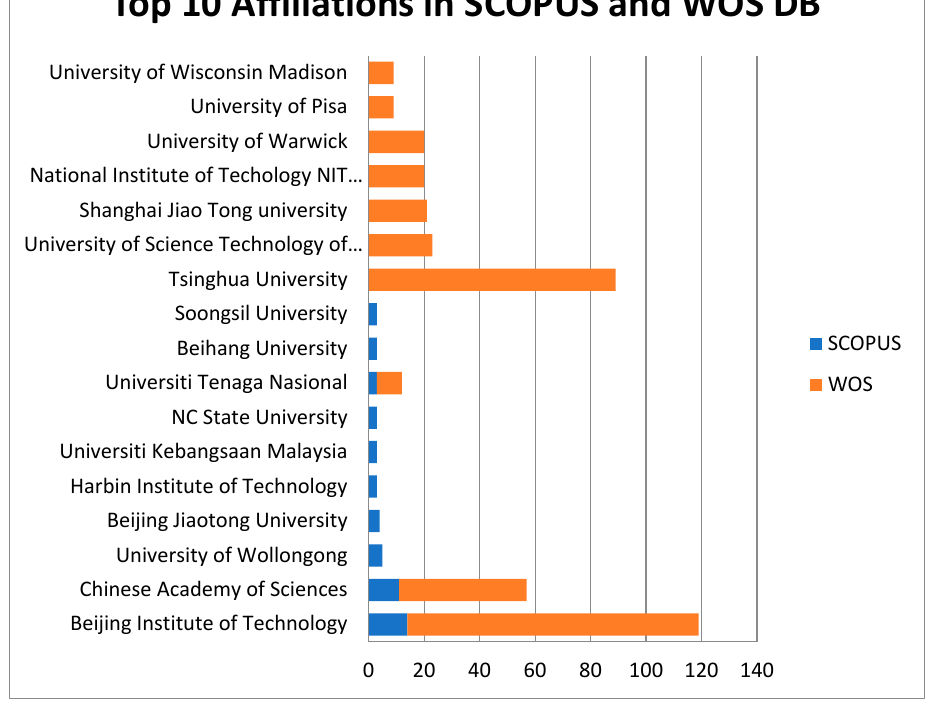
Figure 4. Top ten affiliations in BMS EV in SCOPUS and WOS DB.